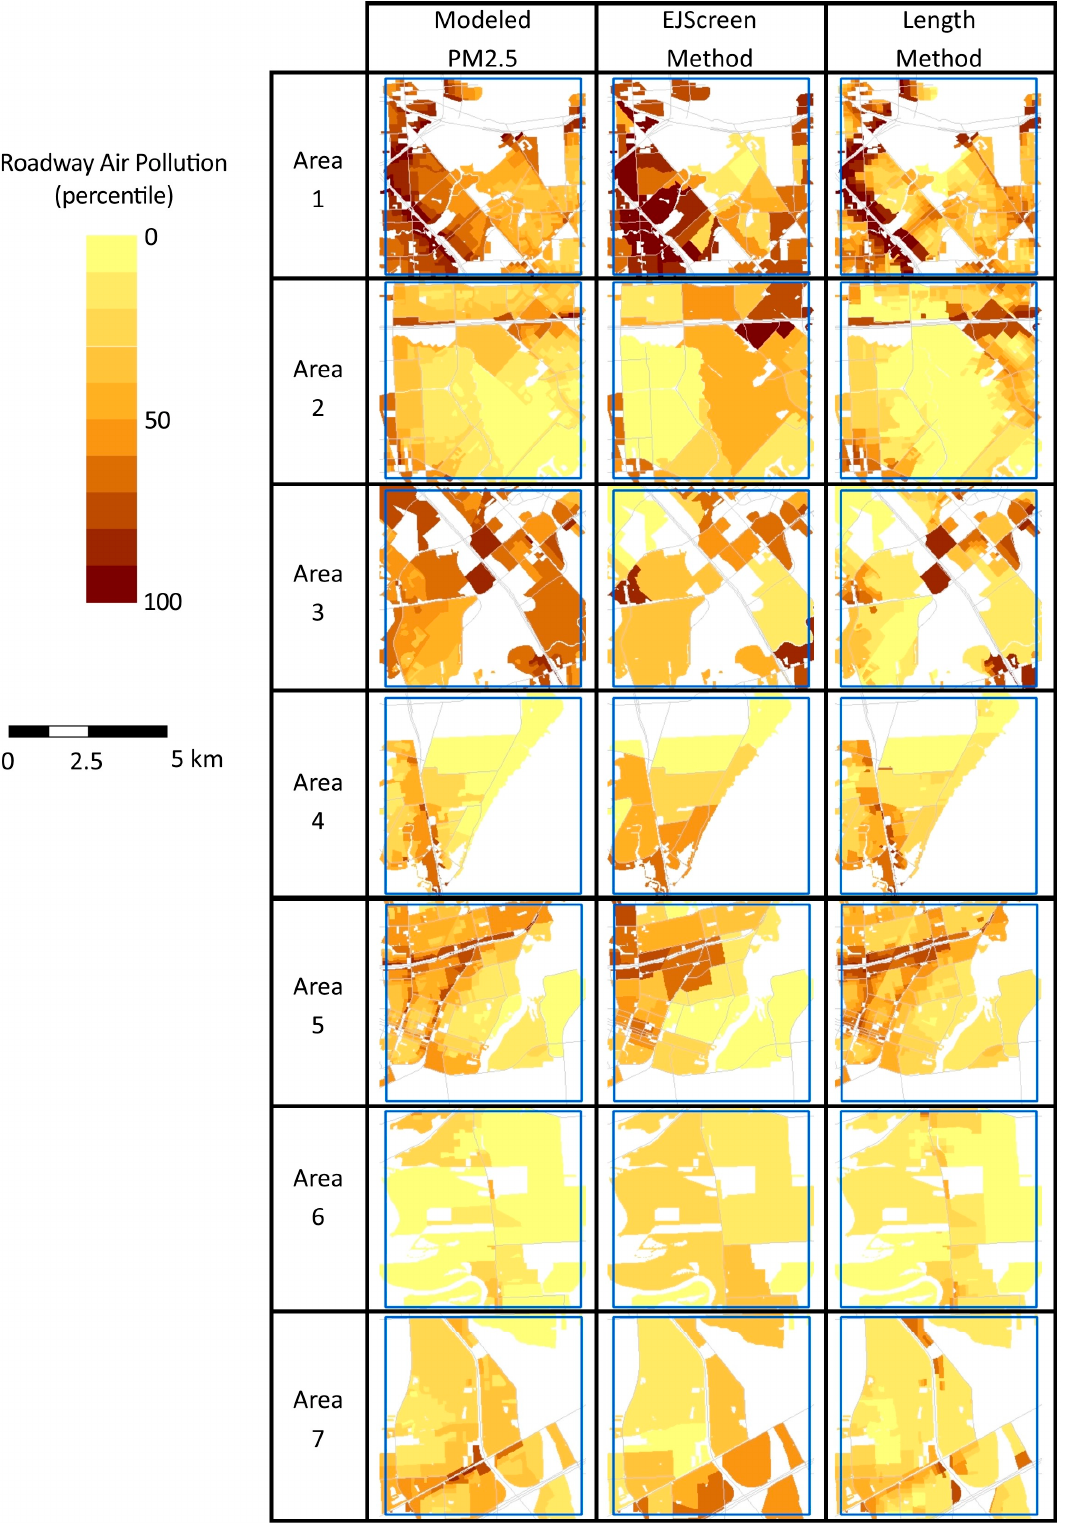
Figure 5. Comparison of modeled PM 2.5 and roadway air pollution indices for populated census blocks using EJScreen and Length methods. The block group level EJScreen estimates are assigned to the corresponding populated census blocks. Percentiles are estimates relative to all sample areas combined.